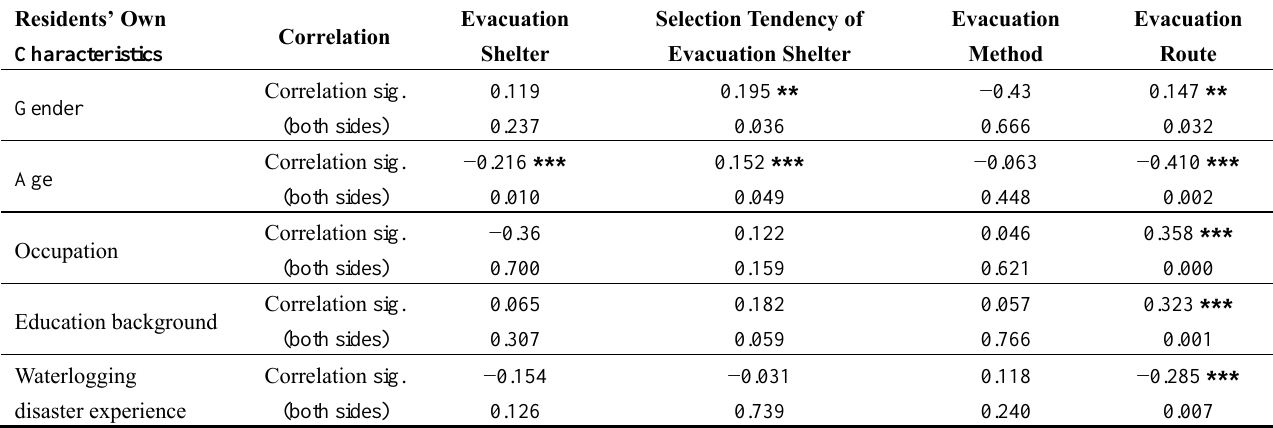
Table 1. Correlation analysis between influence factor and evacuation